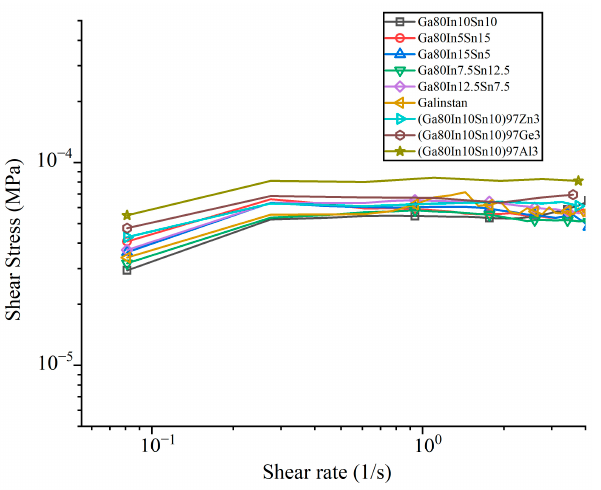
Figure 8. Shear stress is plotted as a function of the shear rate for gallium-based alloys.